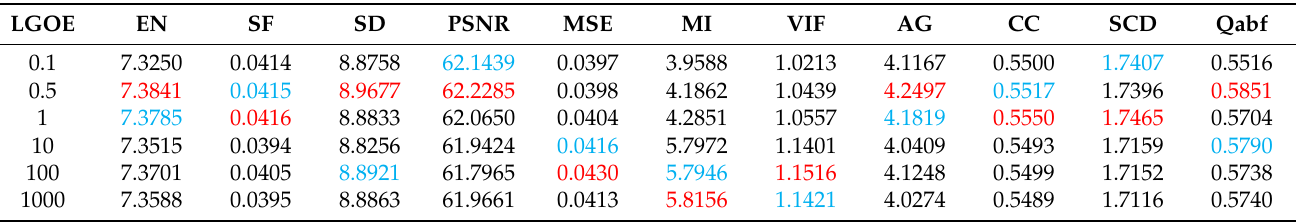
Table 2. The following is the fusion result of different loss function parameters, red is optimal, and blue is